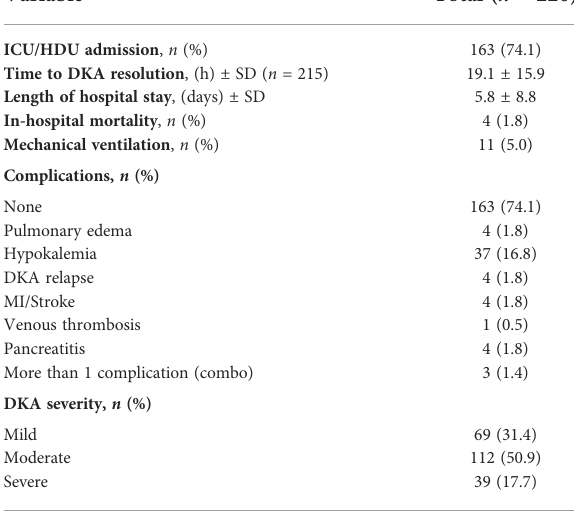
TABLE 3 Diabetes ketoacidosis